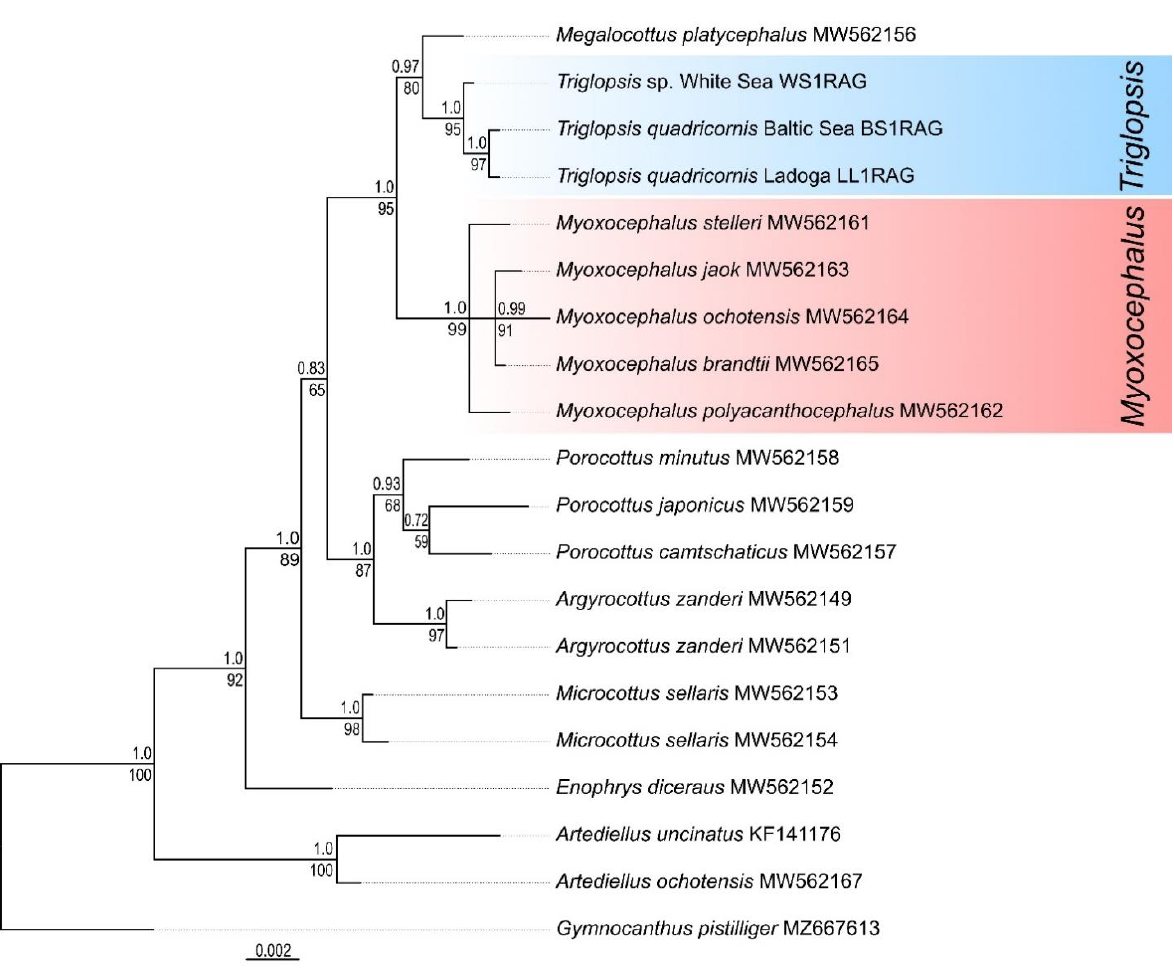
Figure 8. Bayesian phylogenetic tree of marine representatives of the subfamily Myoxocephalinae reconstructed using the sequences of the nDNA RAG1 . For each node, the posterior probabilities (upper number) and the bootstrap values obtained in the ML analysis (lower number) are indicated.